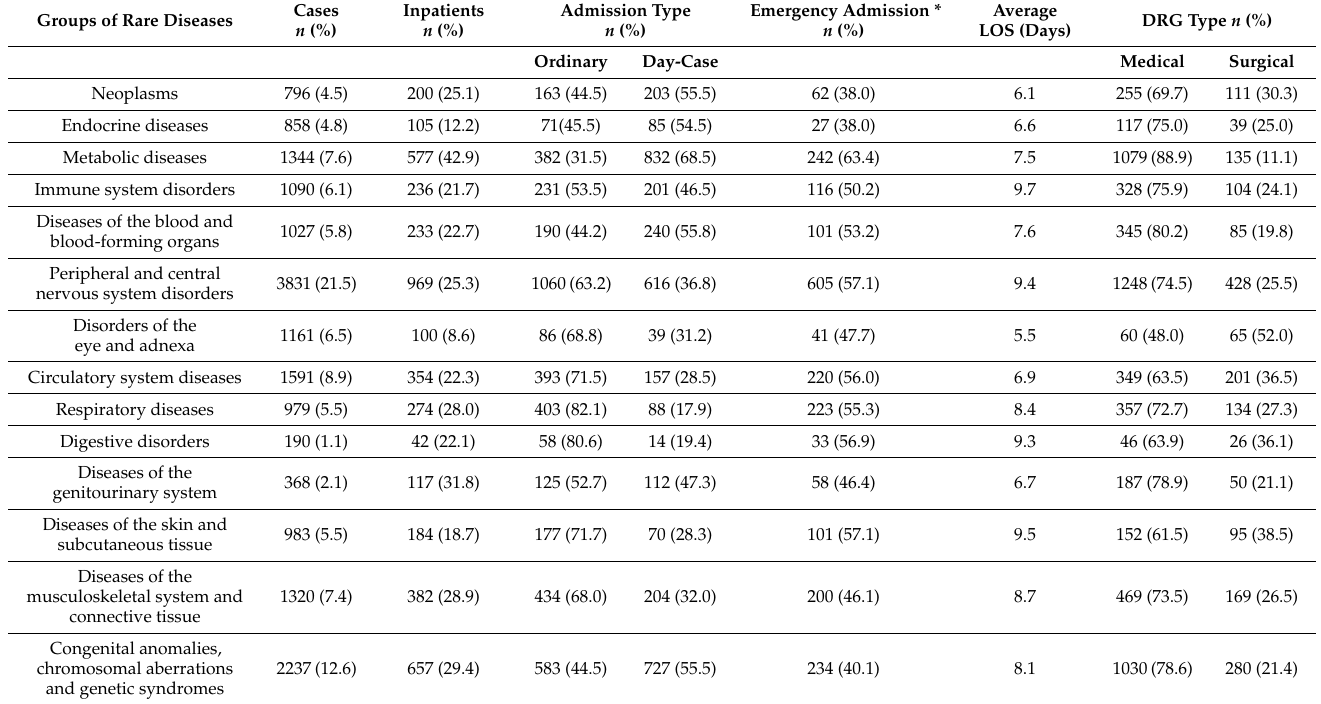
Table 2. Number of cases, proportions of inpatients, admission type (ordinary/day-case), emergency admission, average LOS and DRG type (medical/surgical), by group of rare